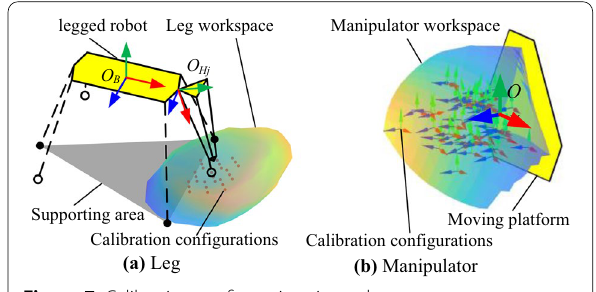
Figure 7 Calibration configurations in